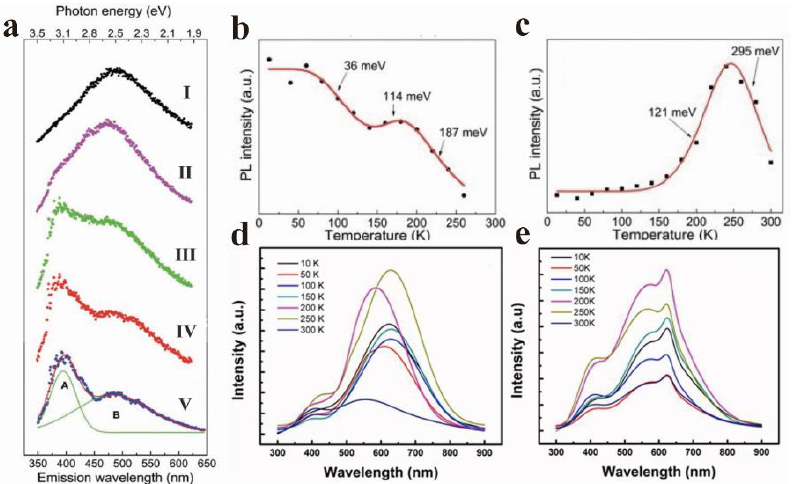
Figure 6. ( a ) PL spectra of GO deposited films at 13 K (I), 140 K (II), 180 K (III), 240 K (IV), and 300 K (V); ( b ) and ( c ) are the change of PL intensity of GO sheet in band A and band B with temperature. Reprinted with permission from [53]. Copyright 2014, Royal Society of Chemistry. ( d ) PL spectra of CRG and ( e ) TRG were obtained at temperatures from 10 K to 300 K. Reprinted with permission from [54]. Copyright 2011, AIP Publishing.